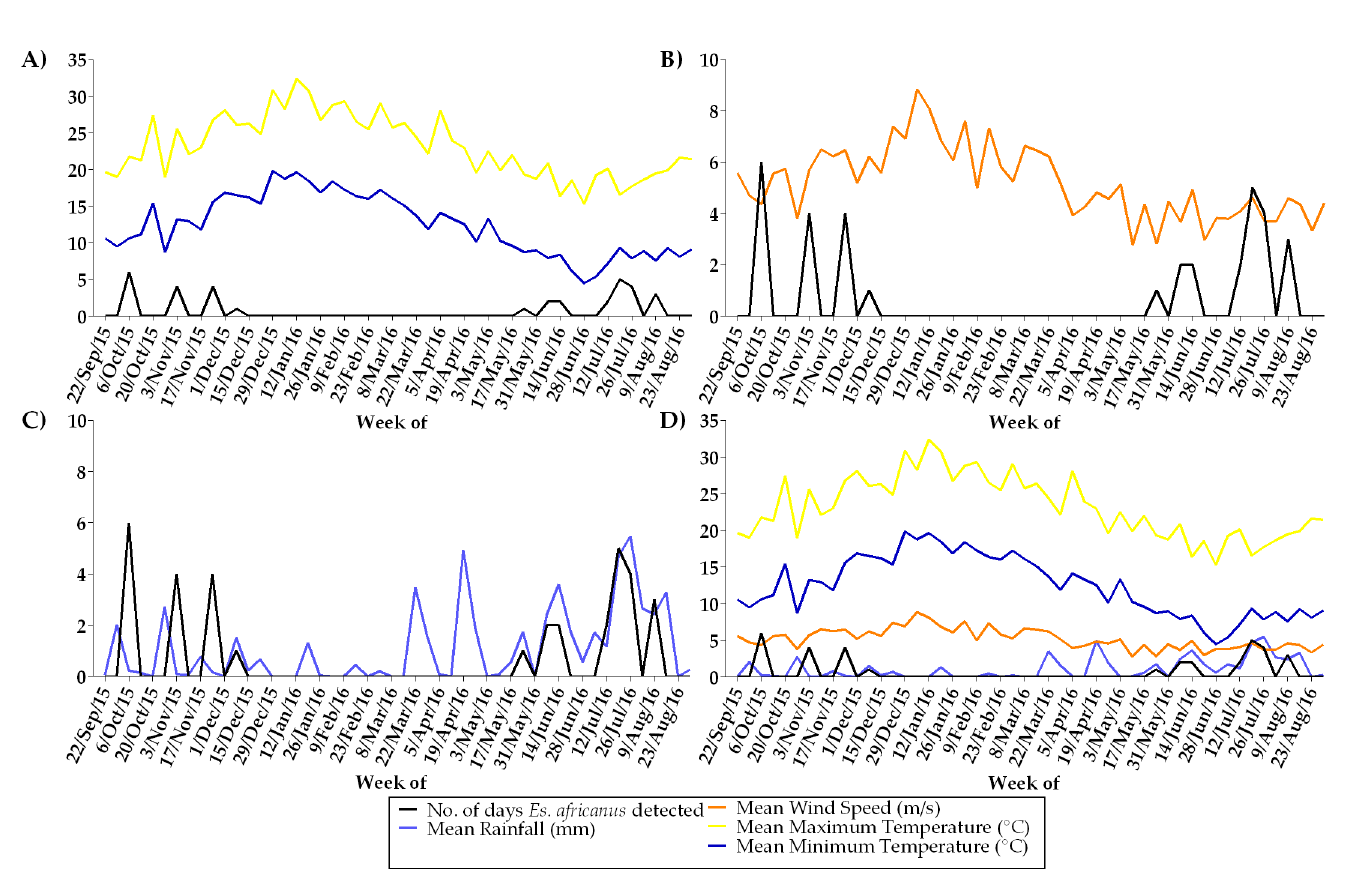
Fig 4. Weather conditions in relation to the detection of airborne propagules of Es . africanus . The number of days per week in which Es . africanus was detected using qPCR is plotted against (A) weekly mean maximum and minimum temperature, (B) wind speed (C) rainfall, and (D) all variables.